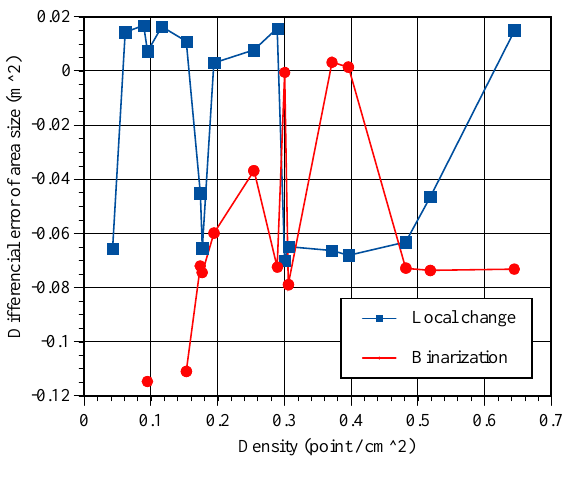
Figure 26. Area size